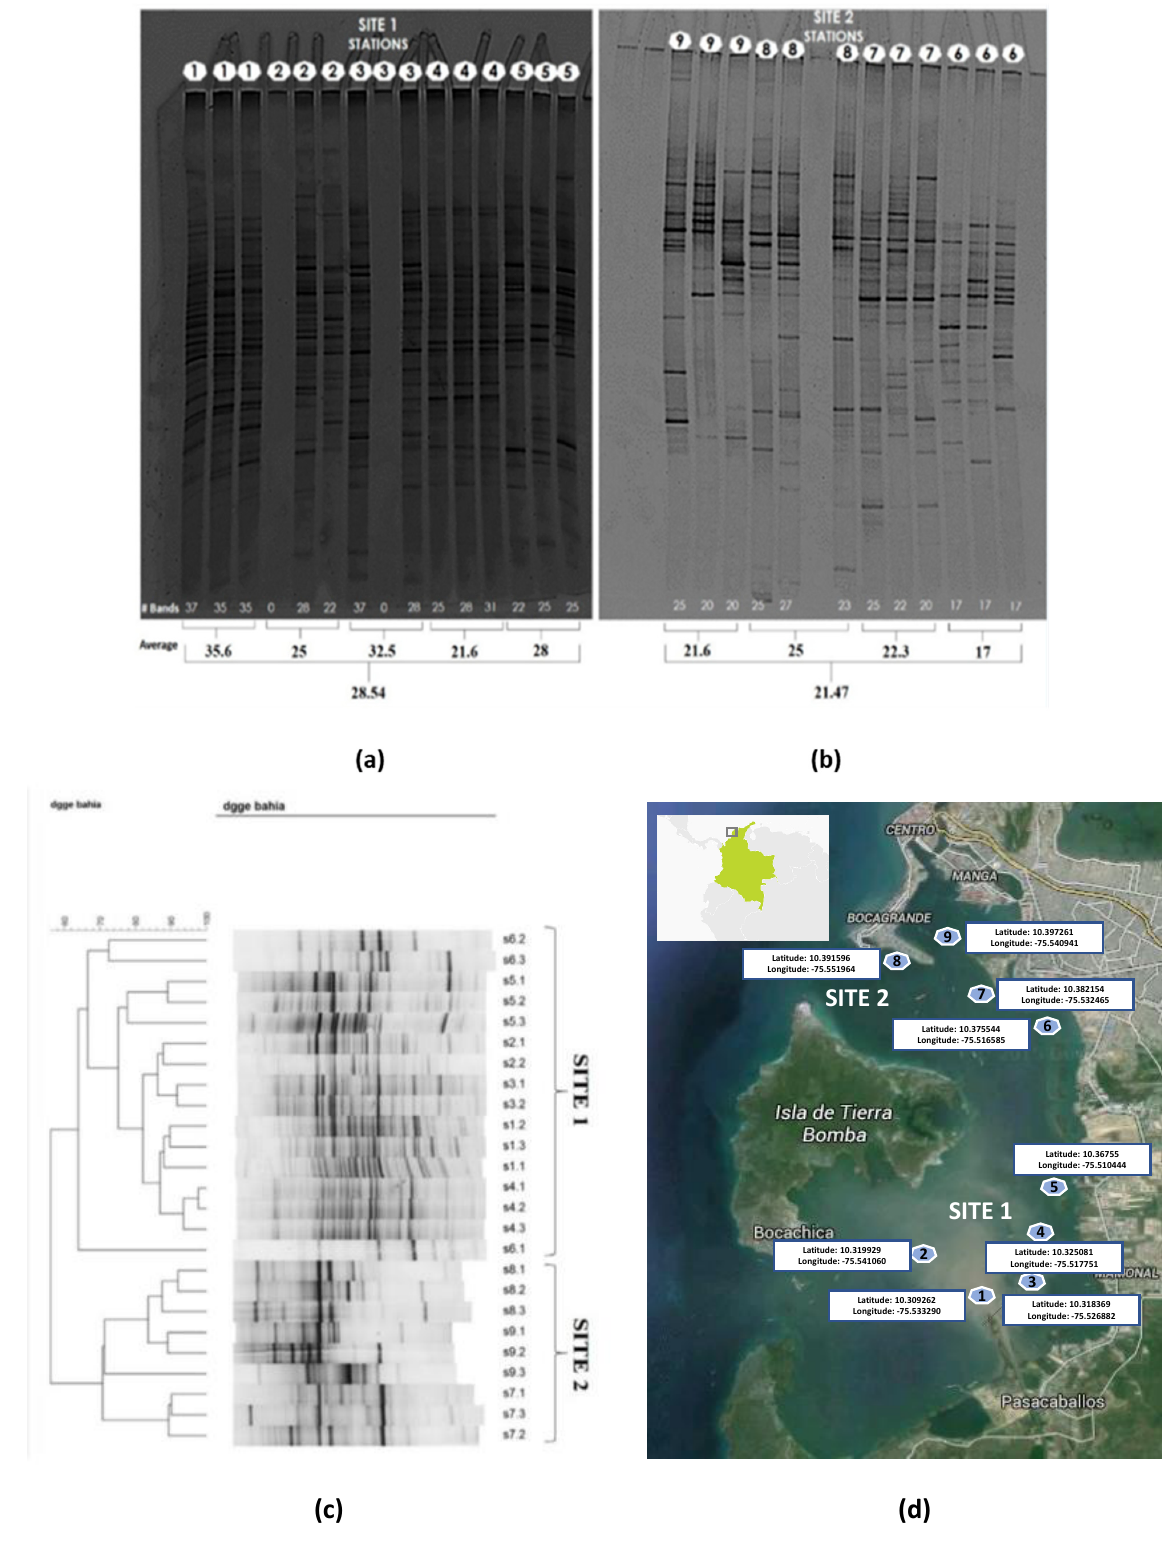
Figure 1. Acrylamide gel and dendrogram DGGE of sediments in Cartagena’s Bay. ( a ) Acrylamide gel in site 1; ( b ) Acrylamide gel in site 2; ( c ) Dendrogram DGGE site 1 and 2 . ( d ) Study area.